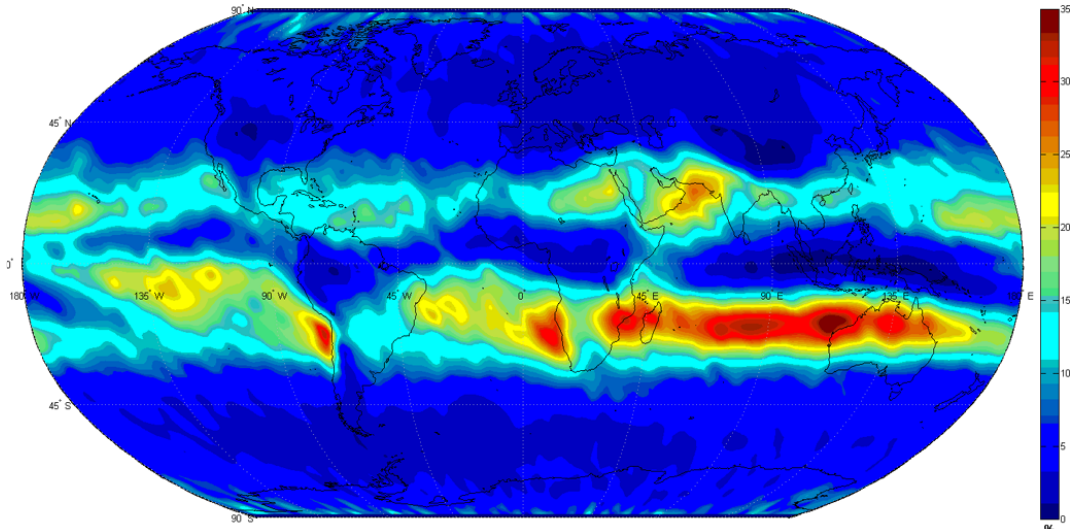
Fig. 8. Distribution of the probability of the profiles which contains extremely small humidity data ( P w < 2 × 10 − 6 hPa). The grid is 5 ◦ × 5 ◦ .